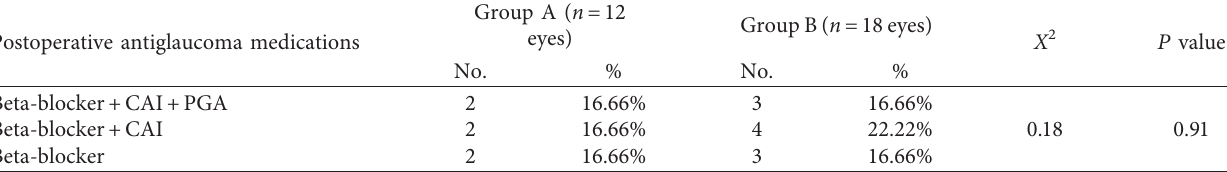
Table 3: Comparison of postoperative antiglaucoma medications between the two groups.